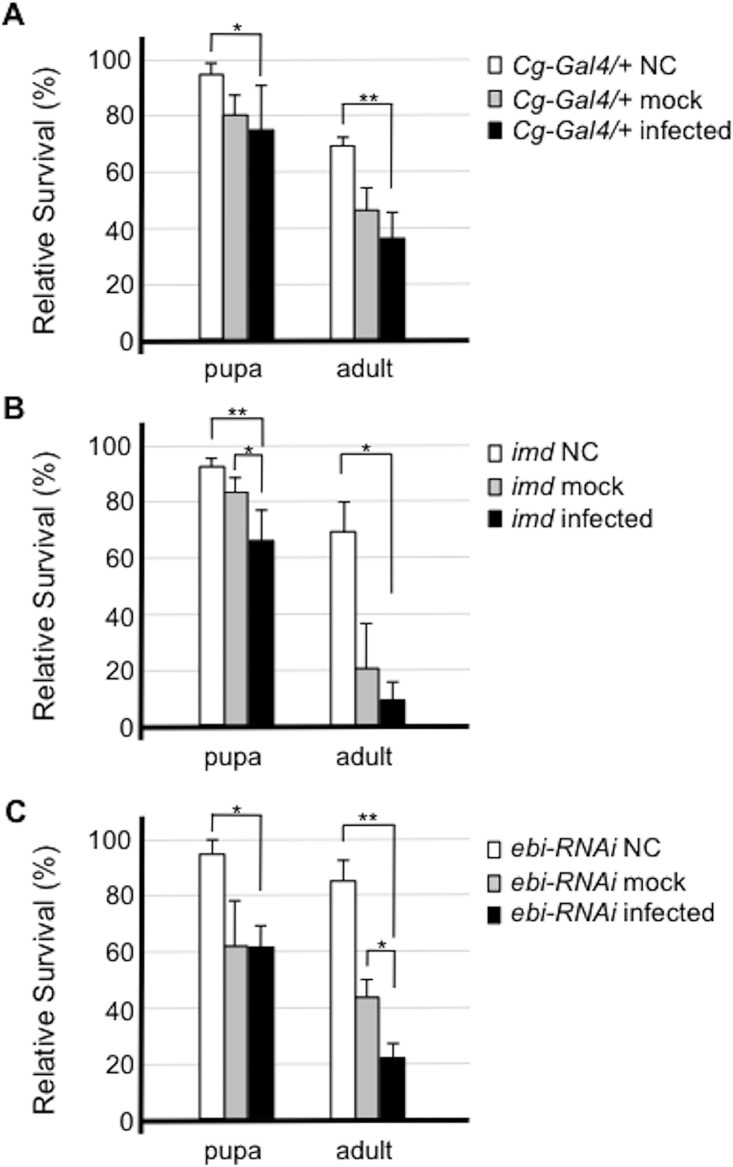
Ebi is involved in the cellular defense response against bacterial infection.Susceptibility to Enterobacter cloacae in flies of each genotype was assessed. Flies were infected with E. cloacae by pricking, and the percentage of surviving flies 2 days after infection was calculated. Error bars denote standard error. The experiment was performed four times. Both Cg-Gal4/+ (control) flies (A) and Imd mutant flies (B) showed increased sensitivity to bacterial challenge. Cg-Gal4>ebi RNAi, in which ebi expression was inhibited, showed enhanced lethality to bacterial challenge (C). Data represent the mean ± SD. *p < 0.05; **p < 0.01. NC: not challenged (not pricked); mock: mock infection (pricked with a clean needle); infected: infected by pricking the insect with a pin inoculated with bacteria.